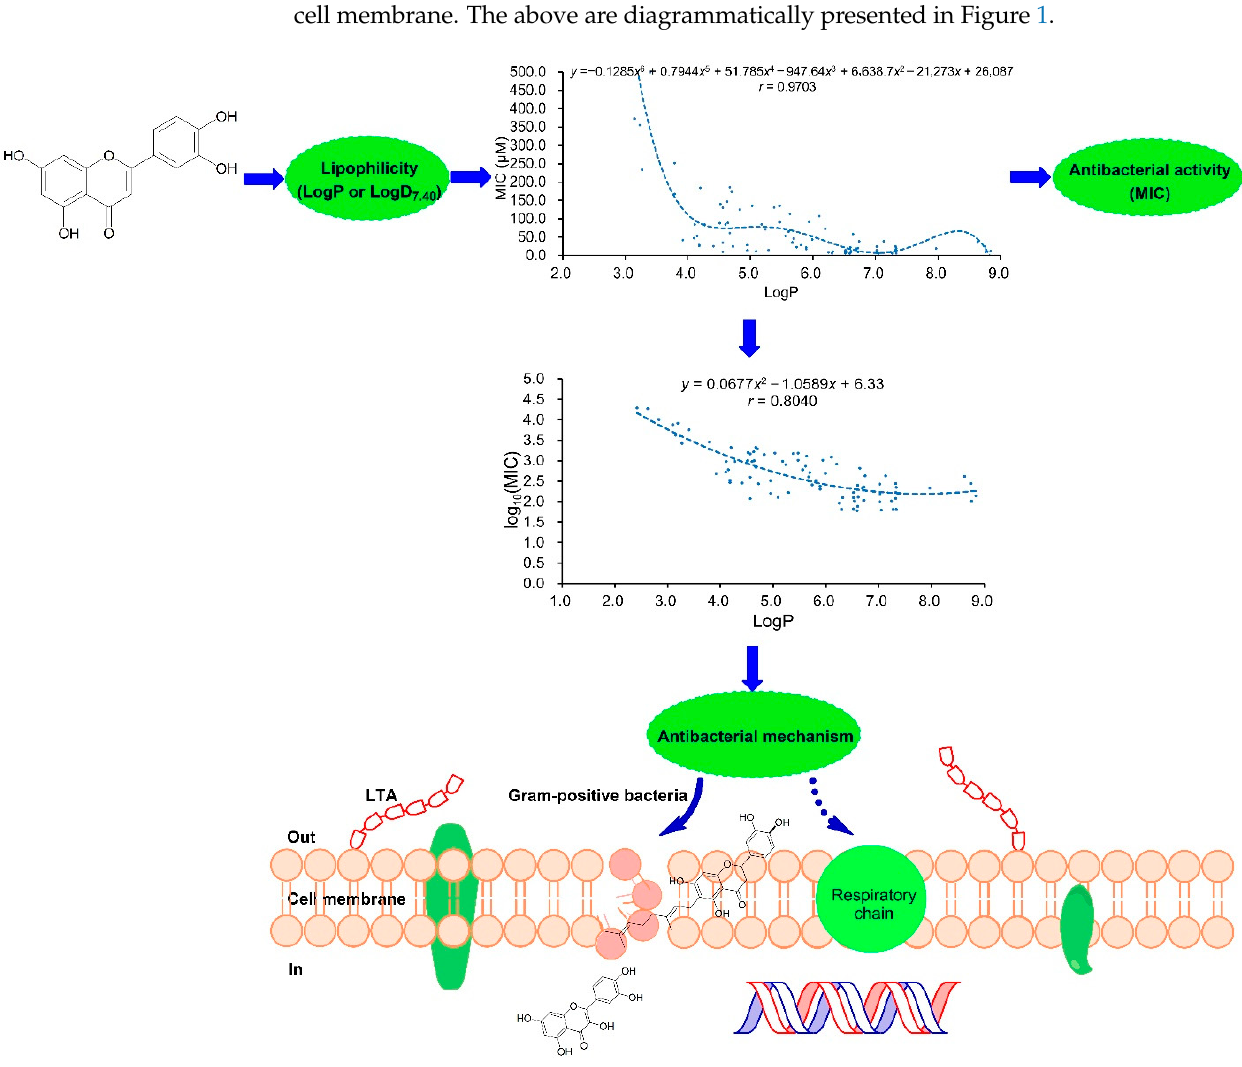
Figure 1. Diagrammatic presentation for the lipophilicity, the antibacterial activities, and the mecha- nisms of plant flavonoids. MIC, minimum inhibitory concentration; LTA, Lipoteichoic